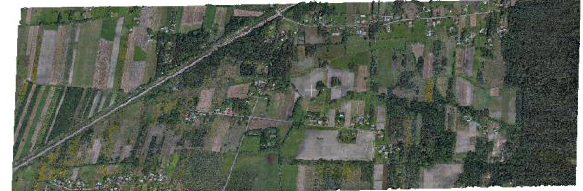
Figure 6. Point Cloud generated from high quality images (good weather condition)